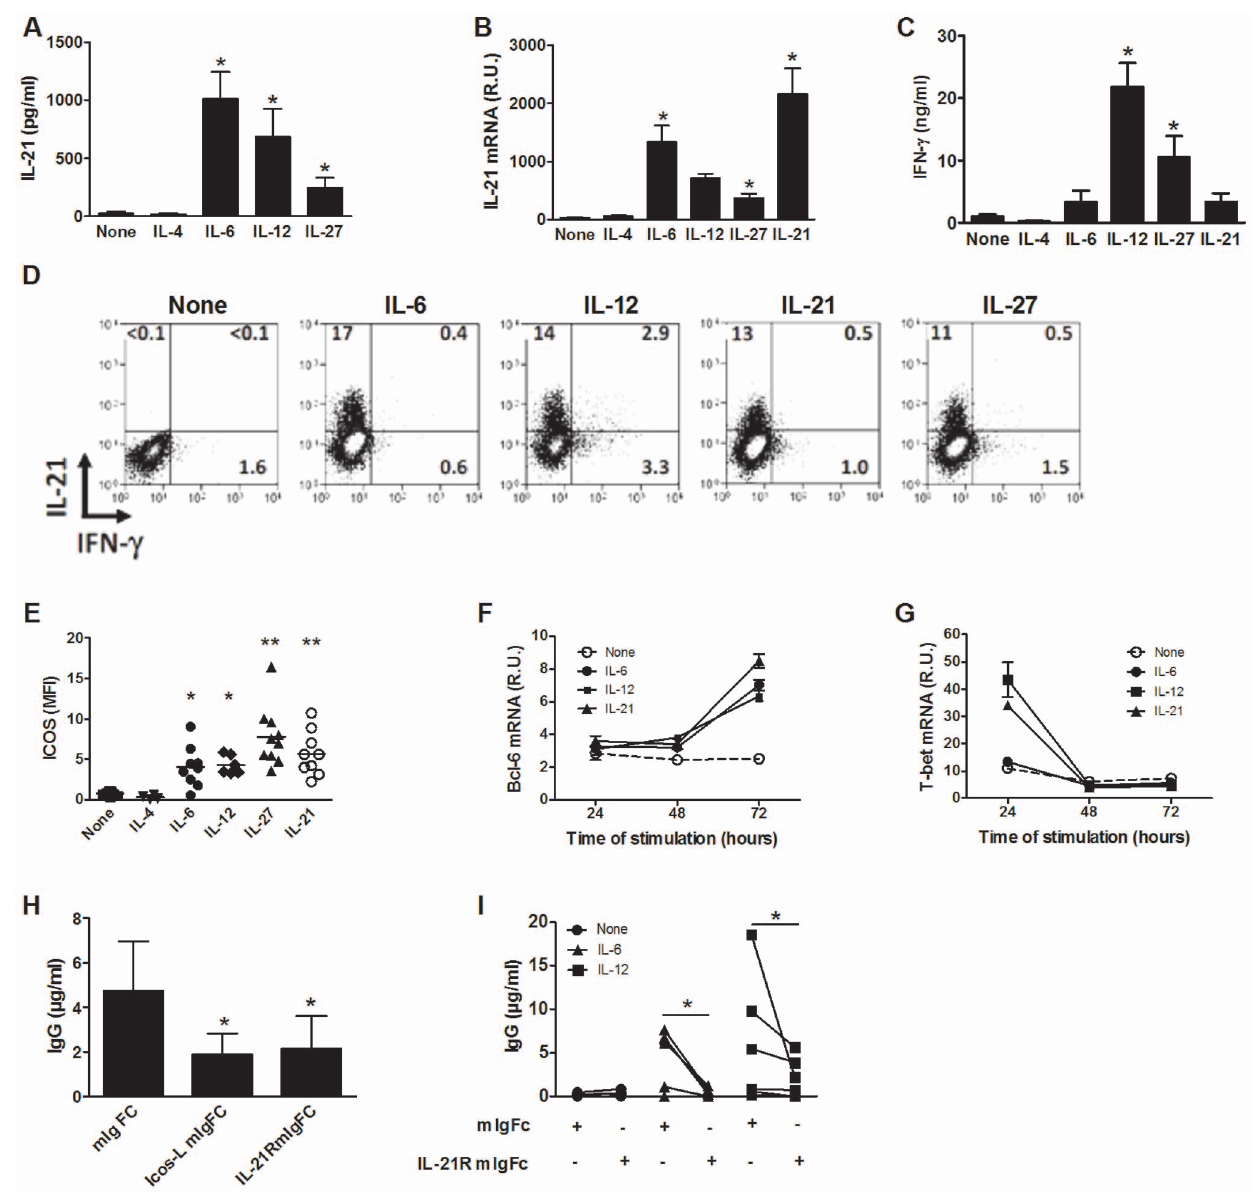
Figure 3. B cell help requires IL-21 production and ICOS expression. A to G) Naive cord blood CD4 T cells were stimulated with anti-CD3 and anti-CD28 mAbs in the presence of the indicated cytokines. Cytokine concentrations were determined on day 3 by ELISA (A and C), by qRT-PCR (B) and by flow cytometry (D). ICOS expression was analyzed by flow cytometry (E). Bcl-6 and T-bet expression was measured by qRT-PCR (F and G). H) Naive cord blood CD4 T cells were stimulated for 3 days with plate bound anti-CD3 (5 m g/ml) and soluble anti-CD28 (1 m g/ml) mAbs in the presence of rIL-6. Cells were then incubated with heterologous B cells and anti-CD3 mAb in the presence of ICOS-L-mIgFc, IL-21RFc or control IgFc before measuring Ig production on day 7. I) Naive cord blood CD4 T cells were stimulated for 3 days with plate-bound anti-CD3 (5 m g/ml) and soluble anti- CD28 (1 m g/ml) mAbs in the presence of rIL-6 or rIL-12 as well as IL-21RFc or control IgFc. Cells were then incubated with heterologous B cells and anti-CD3 mAb before measuring Ig production on day 7. Data are mean 6 SEM of one experiment representative of two (F and G) or 6 to 10 independent experiments (A to E, H and I) except for rIL-12 on panel B (n=4). R.U.: relative units. *p , 0.05, **p , 0.01 as determined by paired Wilcoxon signed-rank test or paired Student’s t-test (rIL-12, panel